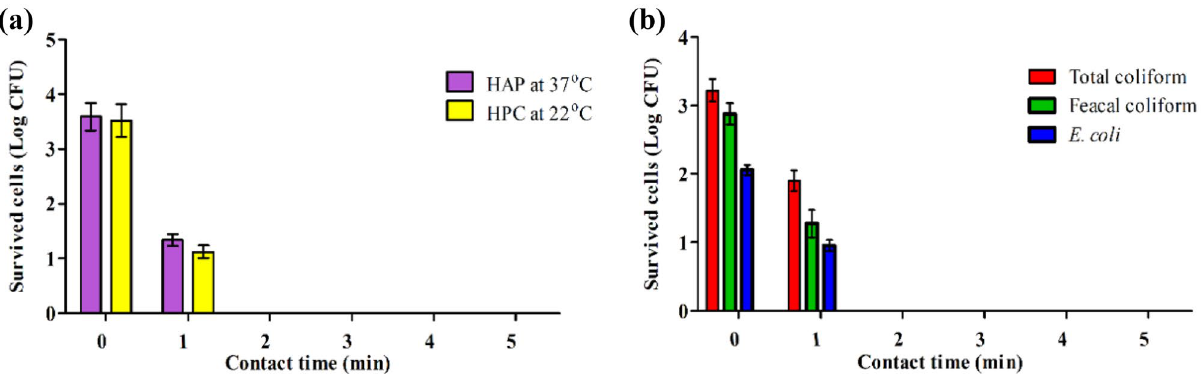
Figure 9. Efficacy of electrochemical disinfection, as a function of time, of some waterborne bacterial species ( a ) HPC at 37 °C and 22 °C, ( b ) fecal bacterial indicator for drainage wastewater under stable